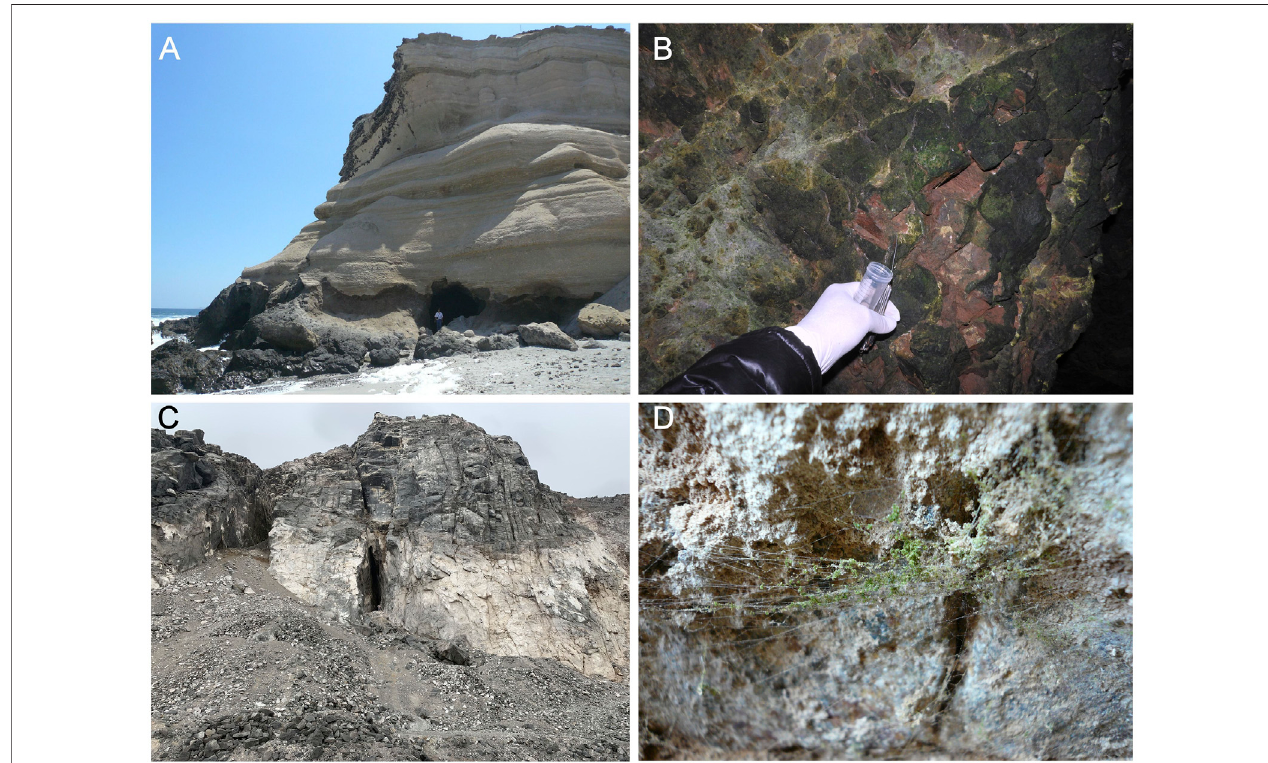
FIGURE 6 | Caves of astrobiological interest in the Coastal Range of the Atacama. (A) La Portada cave near the coastal city of Antofagasta. (B) Cyanidium sp. Atacama epilithic bio fi lms covering the rocks at the bottom of La Portada Cave. (C) Huanillos cave entrance (center of image shown). (D) A spider web colonized with Dunaliella atacamensis cells at Huanillos cave entrance